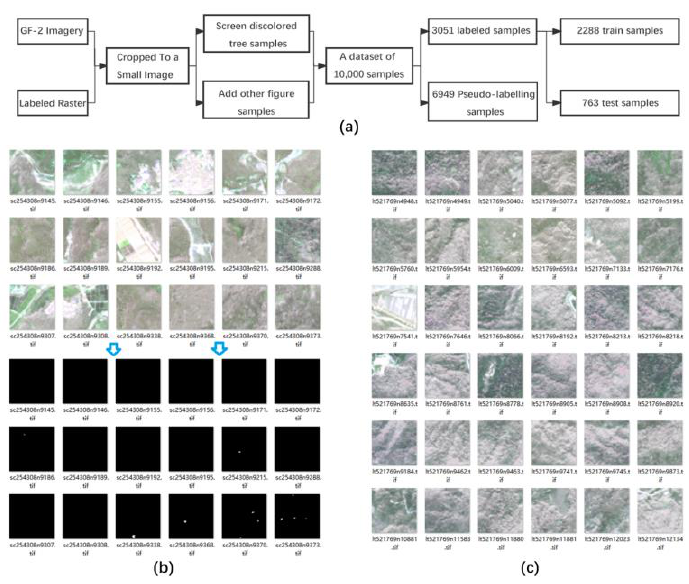
Figure 4. Sample dataset: ( a ) sample dataset creation details, ( b ) labeled samples, and ( c ) unlabeled samples.